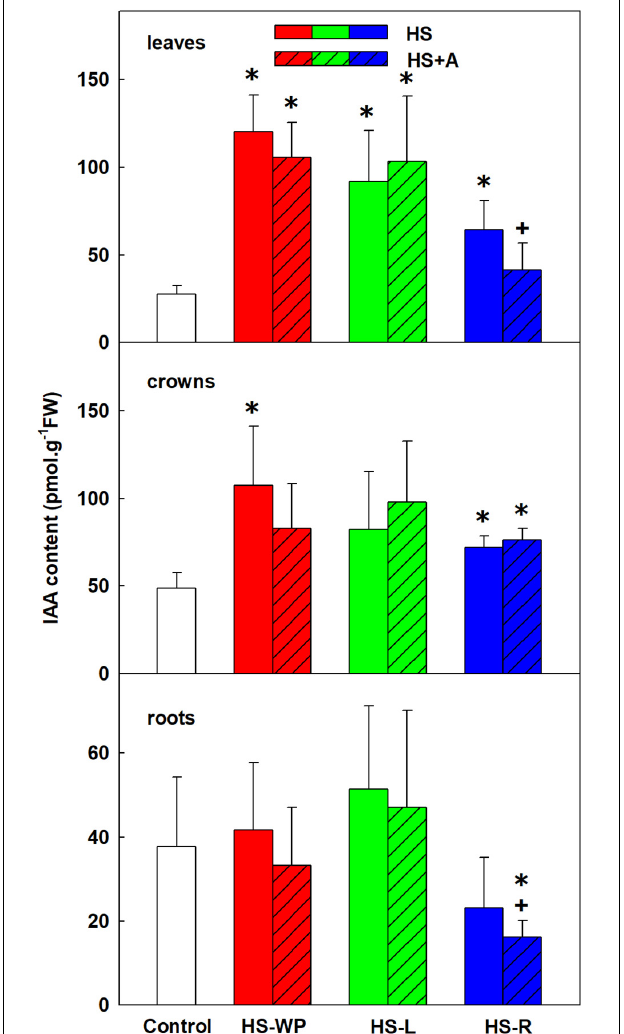
FIGURE 5 | The content of auxin indole-3-acetic acid (IAA) in leaves, crowns and roots of rice seedlings exposed to heat stress directly (HS) or after acclimation (HS + A). Heat stress was applied to whole plants (HS-WP), to leaves (HS-L), or to roots (HS-R). Data are means ± SD. One-way ANOVA with Tukey’s post hoc test ( p < 0.05, n = 6) was used to compare controls to the HS treatments. Significant differences compared to control plants are indicated by asterisks ( ∗ ) while crosses (+) indicate significant differences between HS and HS + A